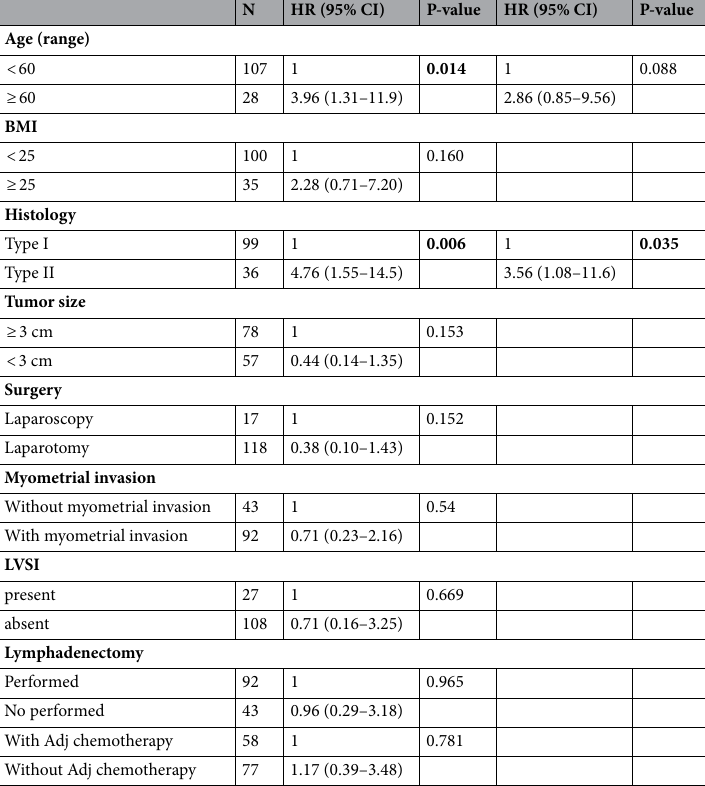
Table 3. Risk factors for recurrence in peritoneal cytology-positive, endometrial carcinoma stage IA patients (univariate and multivariate analysis). BMI body mass index, LVSI lymphovascular space invasion, Adj